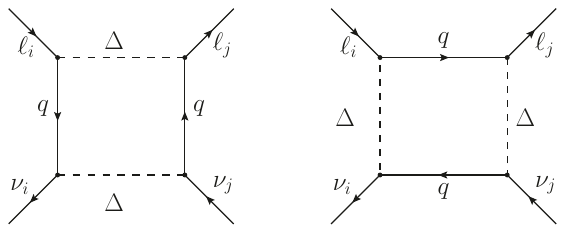
‘ j (cid:23) i (cid:22) (cid:23) j !